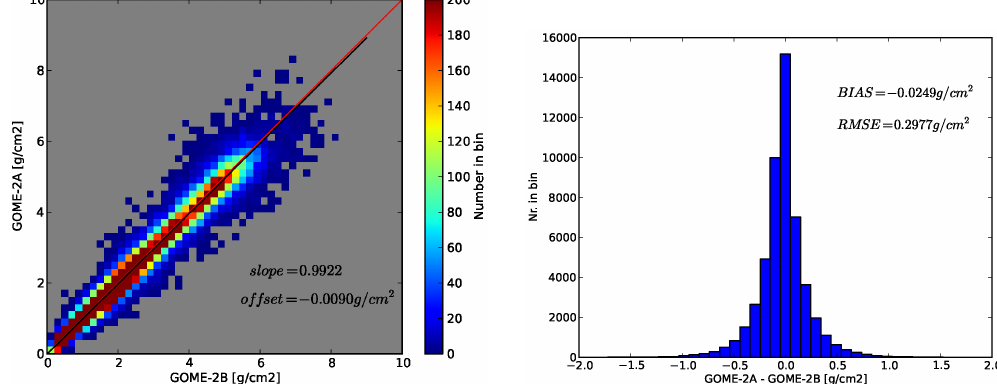
Figure 6. Left panel: scatter plot of GOME-2A monthly mean total columns against GOME-2B monthly mean total columns, for January 2013 and cloud-free sky. The slope of the orthogonal regression is 0 . 992 with an offset of − 0 . 009gcm − 2 . Right panel: histogram of the difference GOME-2A – GOME-2B, for the points in the scatter plot. The mean bias is − 0 . 0249gcm − 2 with a root mean square error of 0 . 297gcm − 2 and a negative skewness.